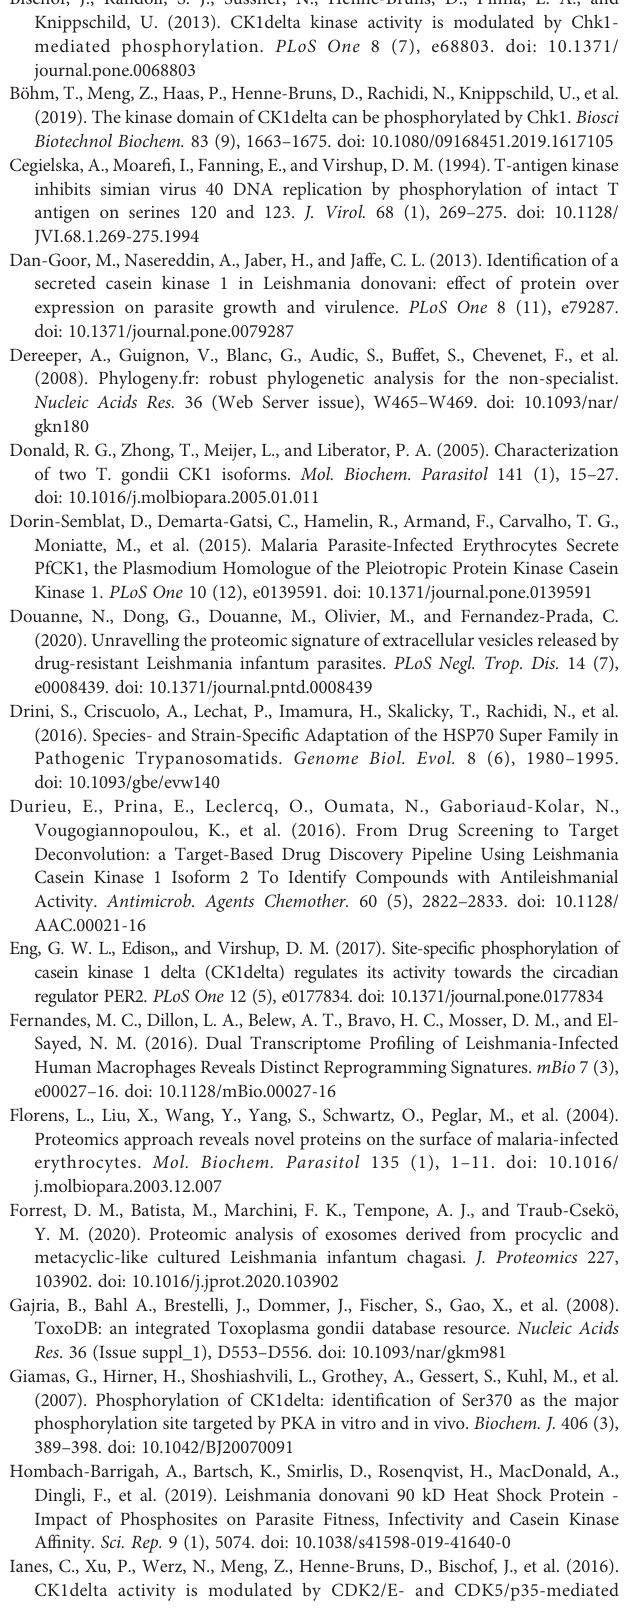
Frontiers in Cellular and Infection Microbiology |